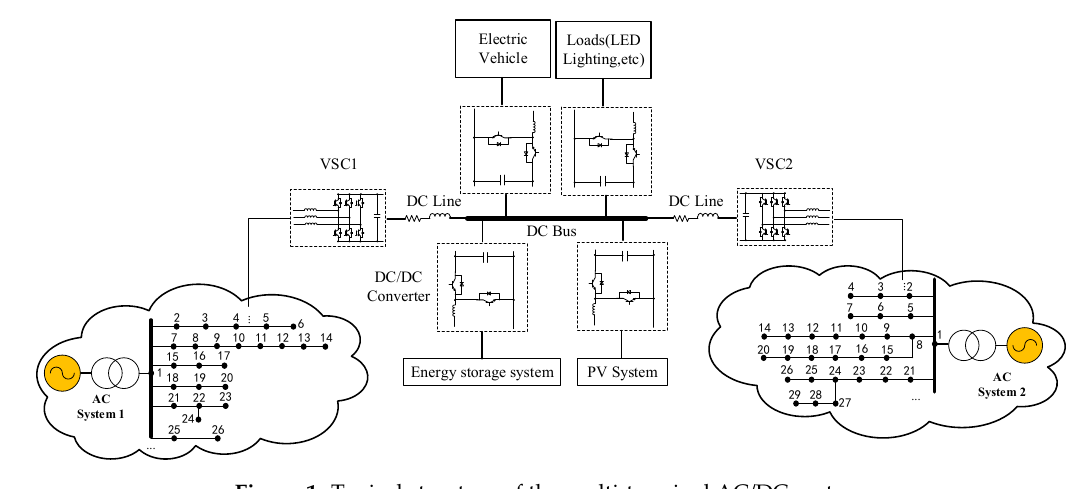
Figure 1. Typical structure of the multi-terminal AC/DC system.